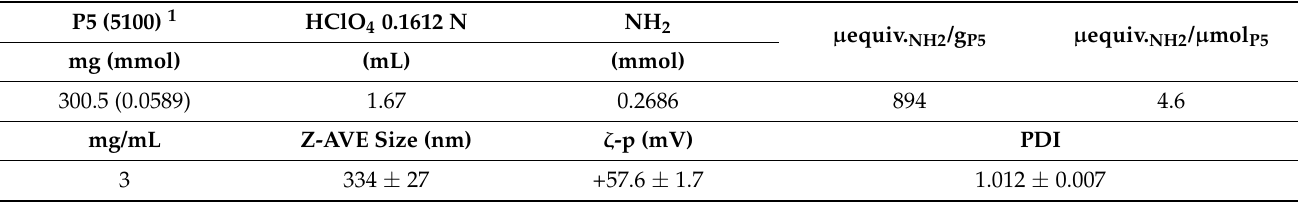
Table 3. Results of volumetric titration of an exactly weighted amount of P5. Hydrodynamic size (nm), ζ -p and PDI at 37 ◦ C of P5 by DLS analysis (degree of freedom =